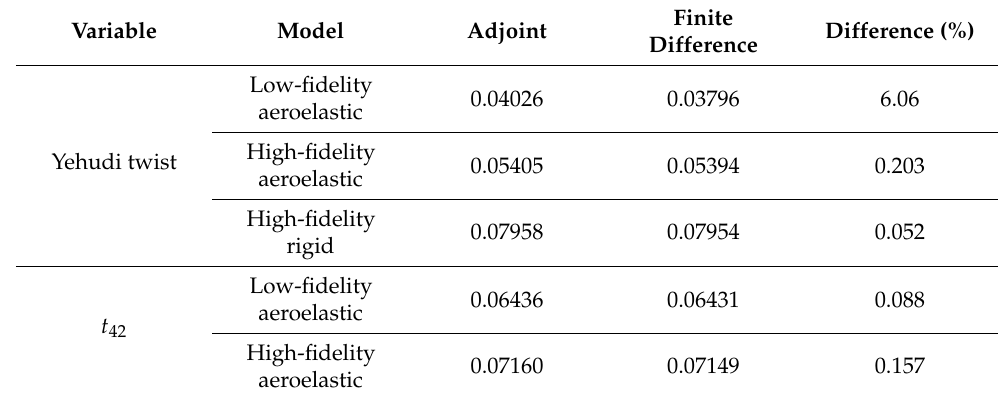
Figure 6. HF adjoint, geometric sensitivities, and their dot product around the baseline aeroelastic solution. ( a ) Log-scale lift coefficient sensitivity. ( b ) Log-scale Yehudi twist sensitivity. Table 2. Derivatives of the lift coefficient with respect to shape and thickness design variables. Finite difference results are forward differenced with a relative step size of 0.01 for the shape variable and 0.0001 for the structural